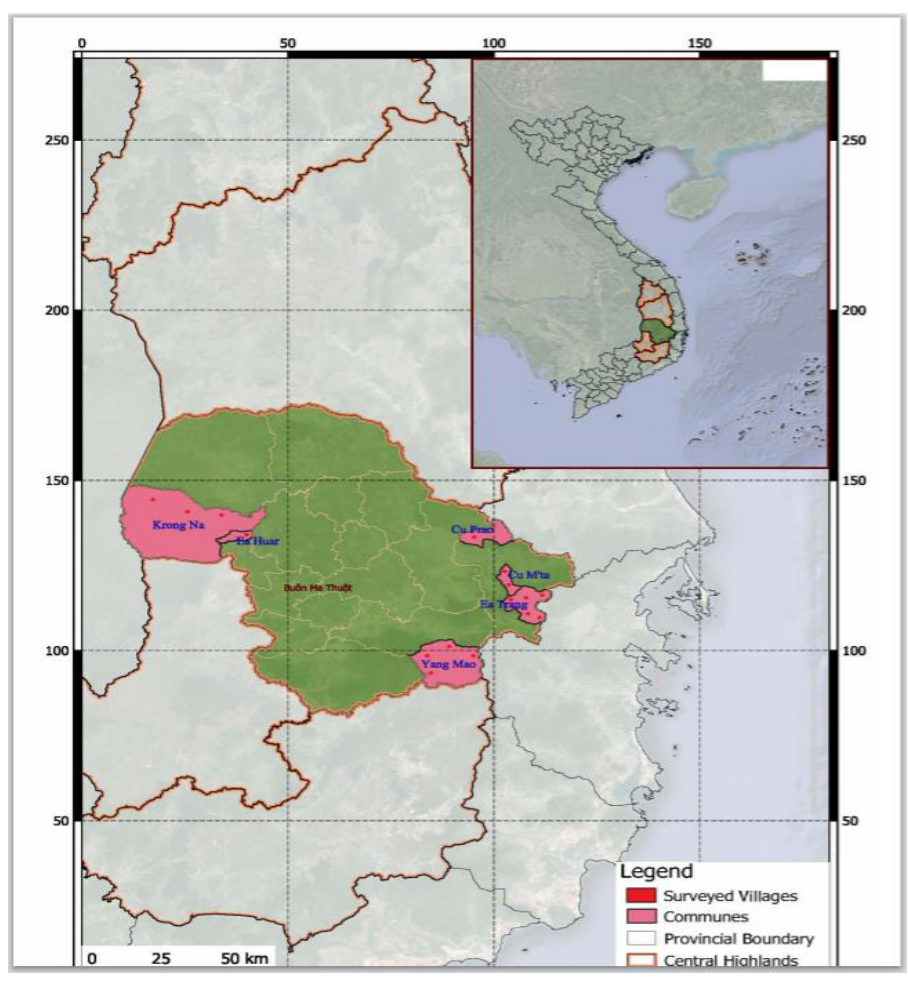
Figure 1. Study village locations. Table 1. List of study